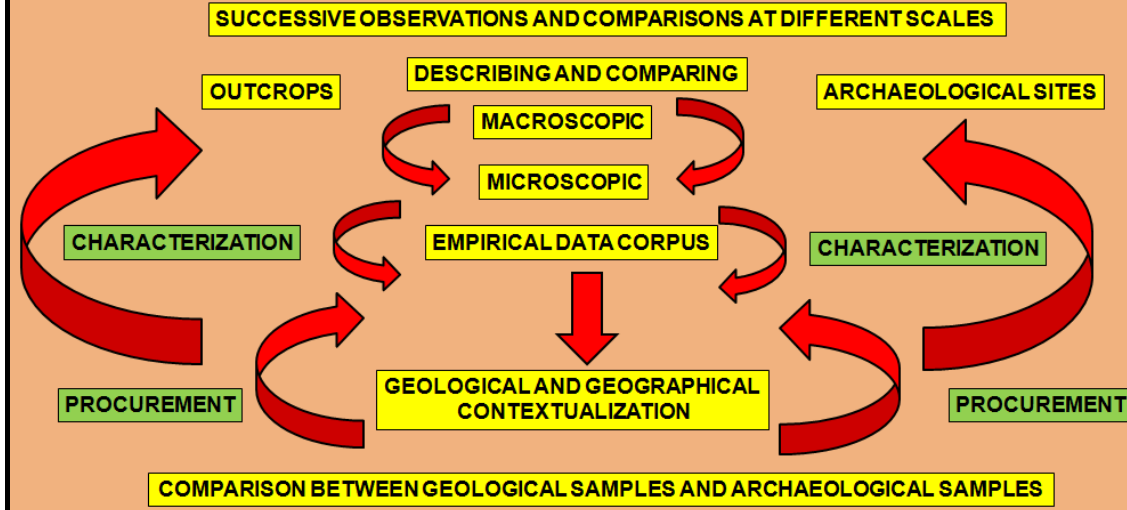
Figure 1. Petroarcheological methodology (Mangado & Rey-Solé,